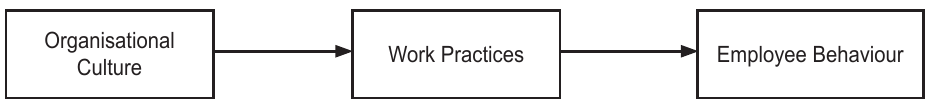
Figure 1: Factors influencing tacit